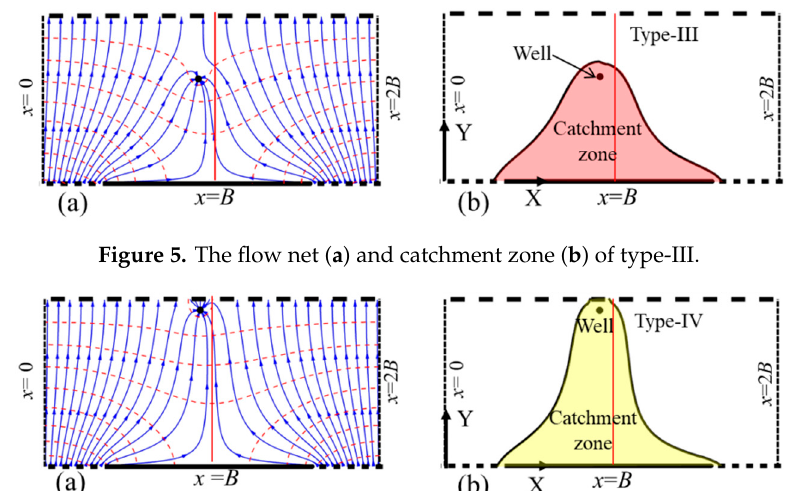
Figure 7. General well-location zones with respect to different types (from I to IV) of the catchment zone. Distribution of the well location zone depends on the control parameters, α , β , γ , and λ , that defined in Equation (7). In particular, Figure 8 shows the change in the well-location zones with the increasing λ value. An increase in the λ value indicates a relative increase in the well pumping rate ( Q w ), which will reduce the area of the I zone and enlarge the area of the IV zone. When the λ value is small, like that shown in Figure 8a, the II and IV zones will be limited in small areas in the vicinity of the discharge boundary. While if the λ value is close or equal to 1.0, the I zone will significantly shrink to a narrow small area that encloses a short part of the Y -axis, as shown in Figure 8d. The IV zone extends to the X -axis in this situation, indicating that the constant head boundary could be connected with the catchment zone for a well pumped heavy even it is very close to the X -axis.